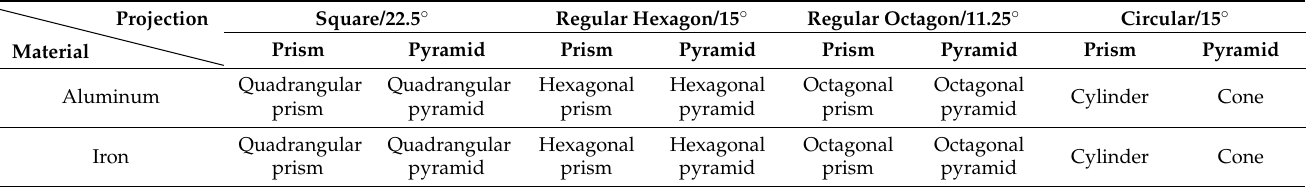
Table 2. Different regular geometric shapes (cylinder and cone), made of aluminum and iron.